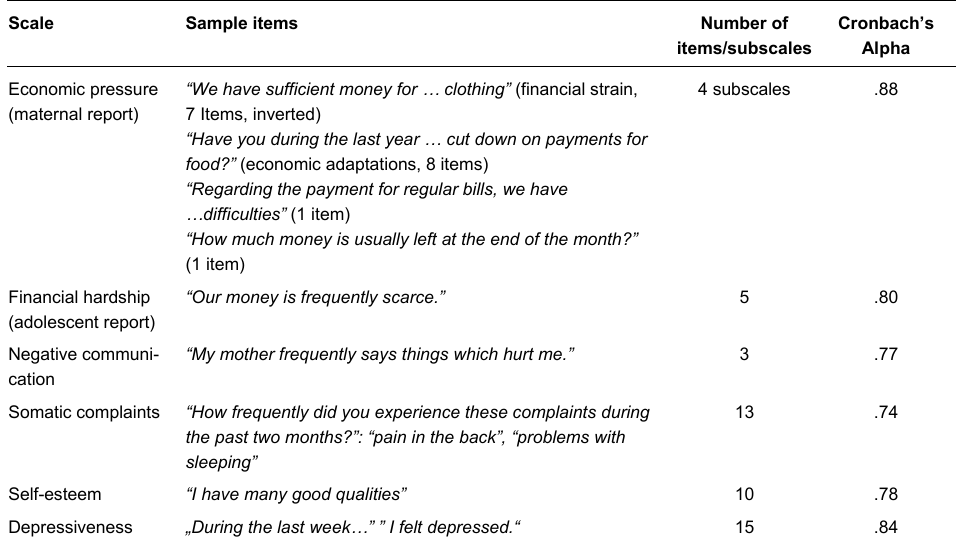
Table 1 : Overview of indicators with sample items and internal